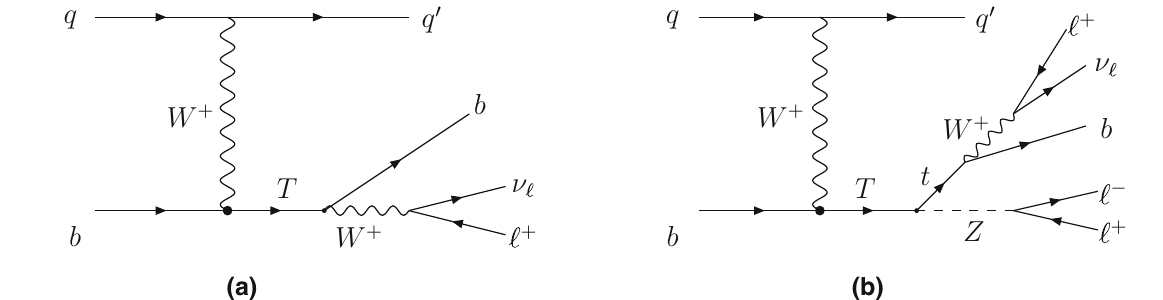
Fig. 2 The Feynman diagram for production of single T quark including the decay chains T → bW ( → (cid:5) + ν) and T → t ( → b (cid:5) + ν) Z ( → (cid:5) + (cid:5) − )